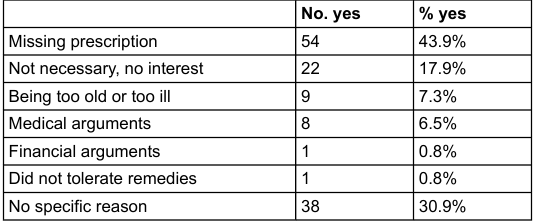
Table 4: Reasons given for why patients did not take specific antios- teoporotic remedies (multiple answers possible, n = 123). No. yes